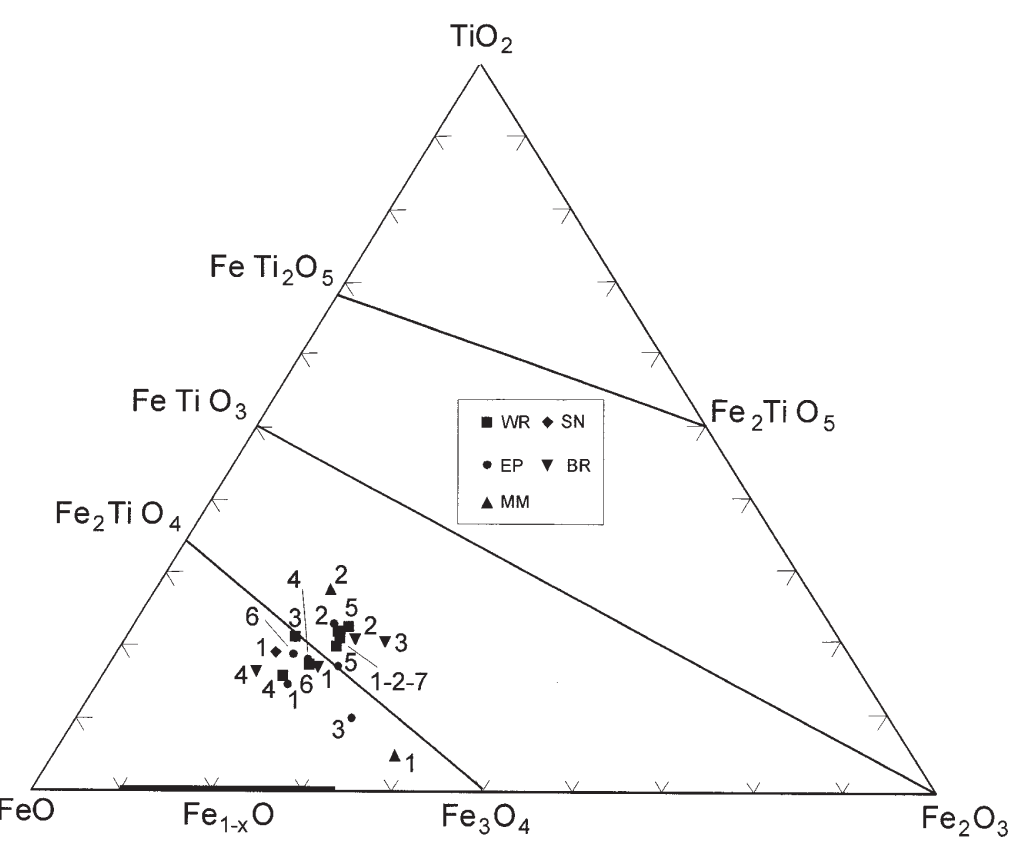
Fig. 6. Composition of the titanomagnetites of the investigated